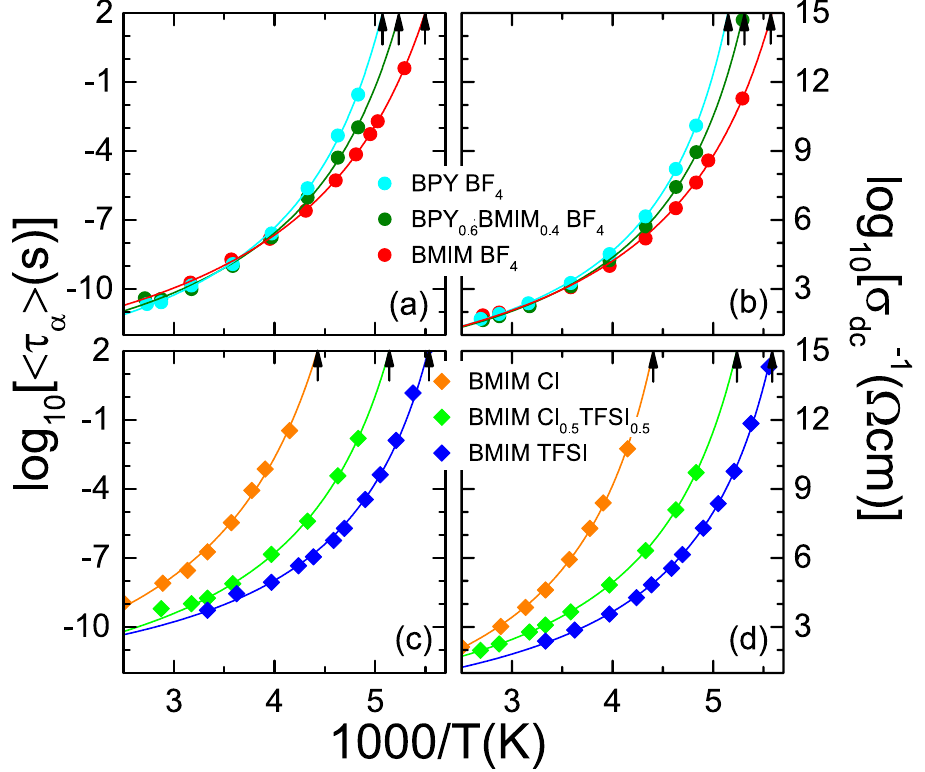
Figure 3. Temperature dependent ionic dynamics of BPY x BMIM 1 − x BF 4 and BMIM Cl x TFSI 1 − x . The relaxation times ( a ) and ( c ) and the dc-conductivities ( b ) and ( d ) are shown in an Arrhenius representation. The data are determined from the fits of the dielectric spectra. The lines are fits with the Vogel-Fulcher-Tammann- equation 63–66 . The arrows denote the glass temperatures, derived from the VFT fits at 100